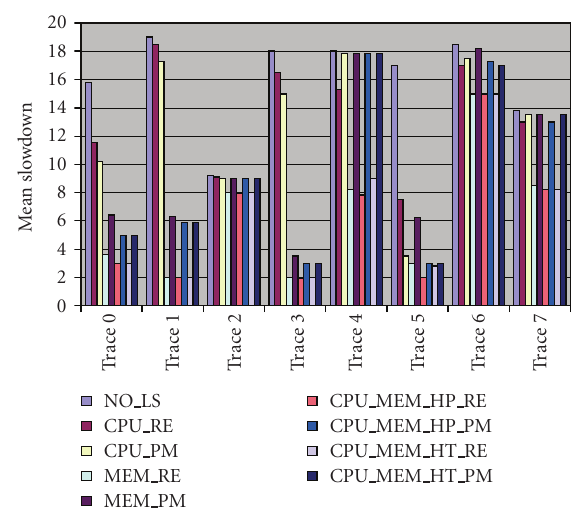
Figure 2: Mean slowdowns of all the 8 traces scheduled by di ff erent load sharing policies with the mean memory demand of 11MB.